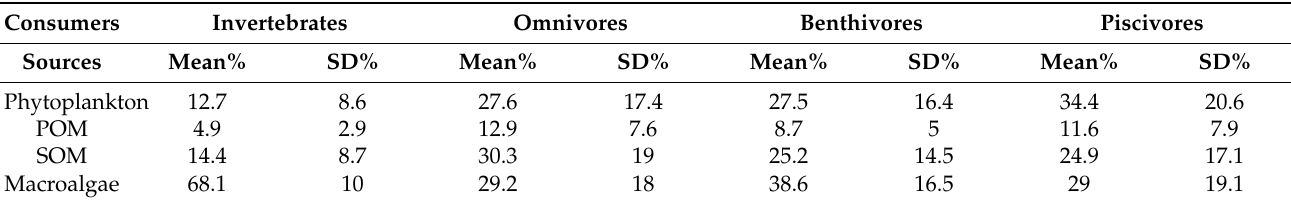
Table 3. Summary statistics of simmr analysis for each group.